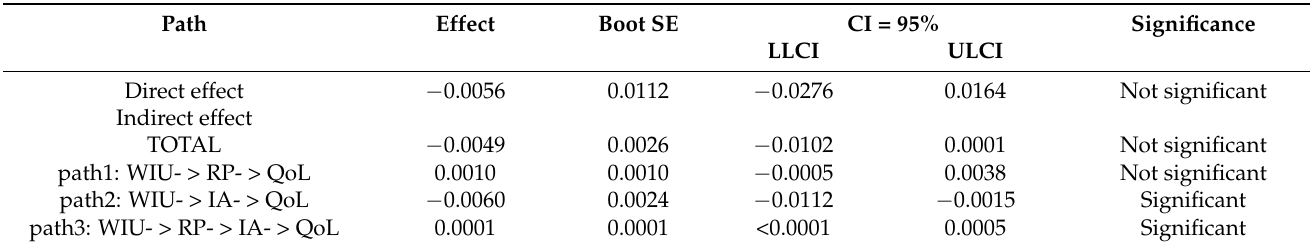
Table 6. Bootstrap analysis of significance test on mediating effect (for